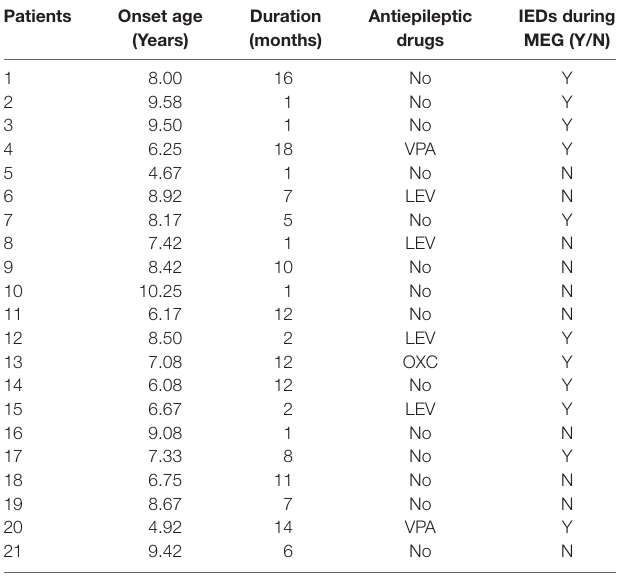
TABLE 1 | Clinical characteristics of benign epilepsy with centrotemporal spikes (BECTS) patients. Patients